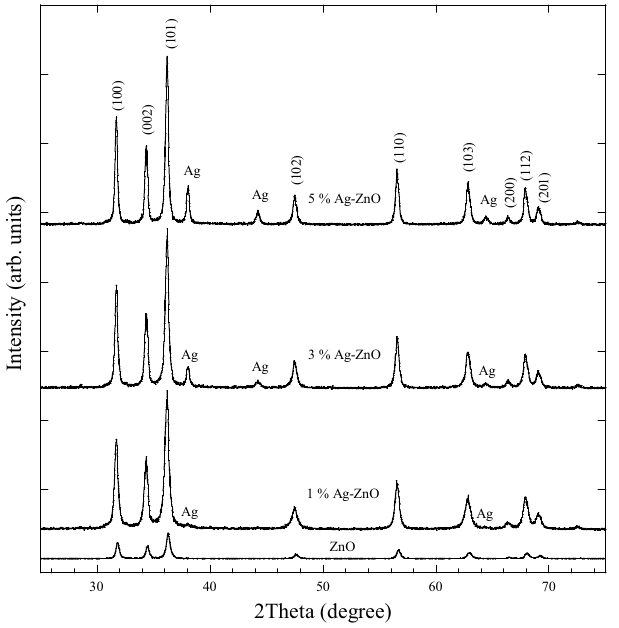
Figure 2. XRD patterns of pure and ZnO doped with Ag nanopowders.